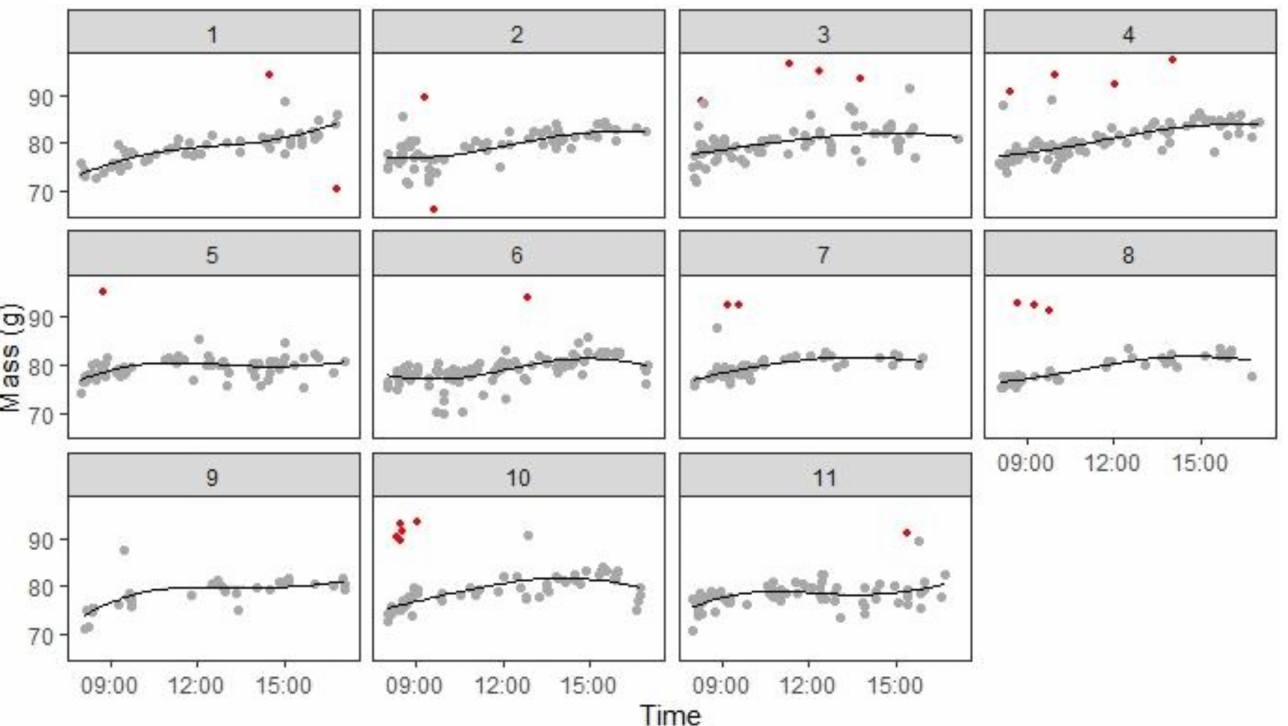
Figure 3. Example of raw mass data from one bird. Panels 1–11 show scatterplots of individual stable mass measurements (g) by time of day (hours) for 11 consecutive days of continuous foraging under closed economy. Red points indicate masses that were excluded from the final model due to falling more than 10 g from the initial cubic fits (see Methods for details). The black line shows the cubic fit to the remaining grey points that was used to derive the estimated masses for specific times of day. Data from bird P77 are shown; equivalent graphs for the other 11 birds are shown in Supplementary Figures